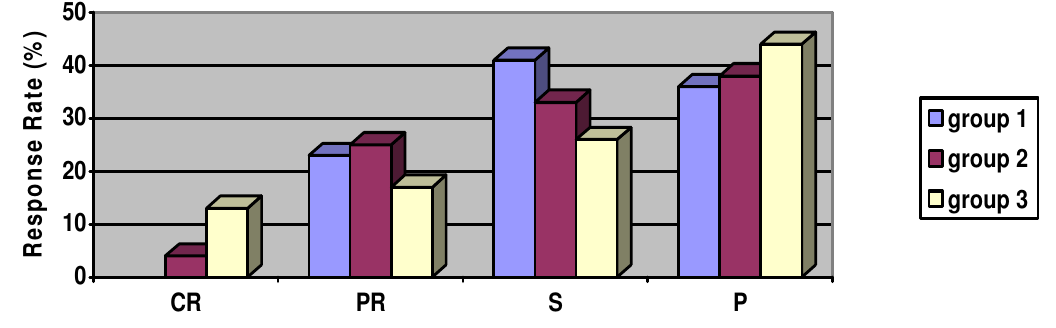
FIGURE 1. The assessment of response according to the treatment groups at the end of 3 months (CR: complete response, PR: partial response, S: Stable, P: